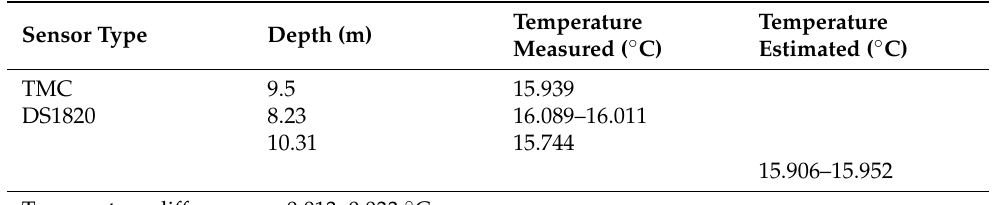
Table 6. Temperature comparison between the two sensor types.